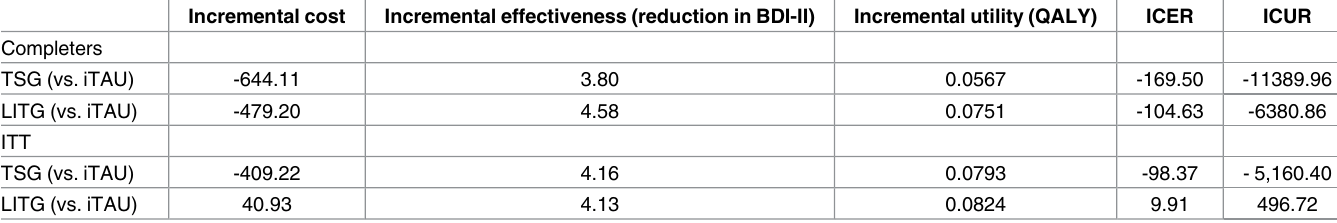
Table 4. Incremental cost, effect, utility, and cost-effectiveness/cost-utility ratios from the societal